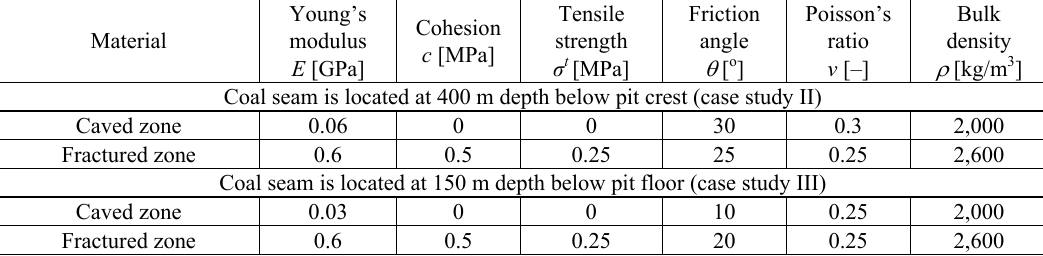
Table 5. Mechanical parameters of caved zone and fractured